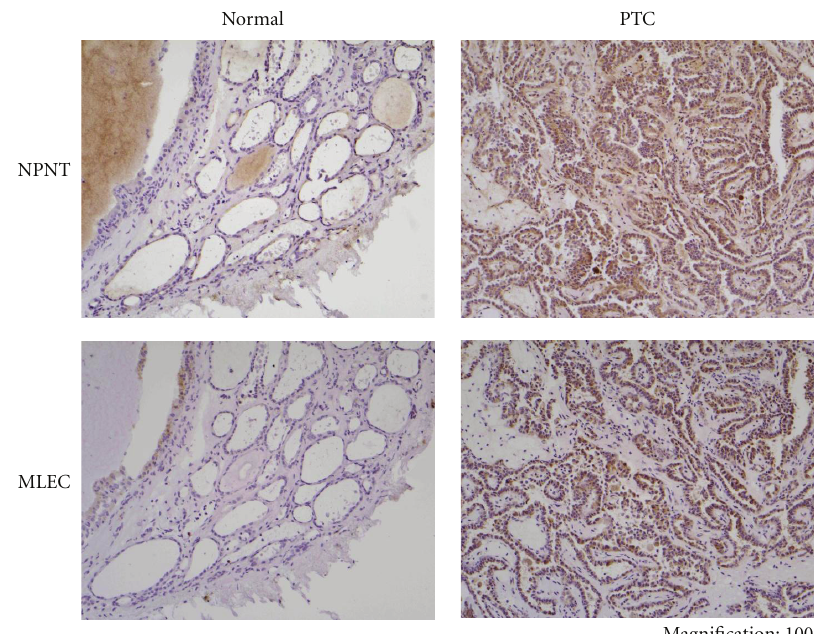
Figure 5: Immunohistochemical localization of NPNT and MLEC in normal thyroid tissue and PTC. Only weak staining of NPNT and MLEC were observed in follicular epithelium of normal thyroid tissue (surrounding tumor). In PTC, strong staining was seen with both antibodies (Normal: normal thyroid tissue, PTC: Papillary thyroid